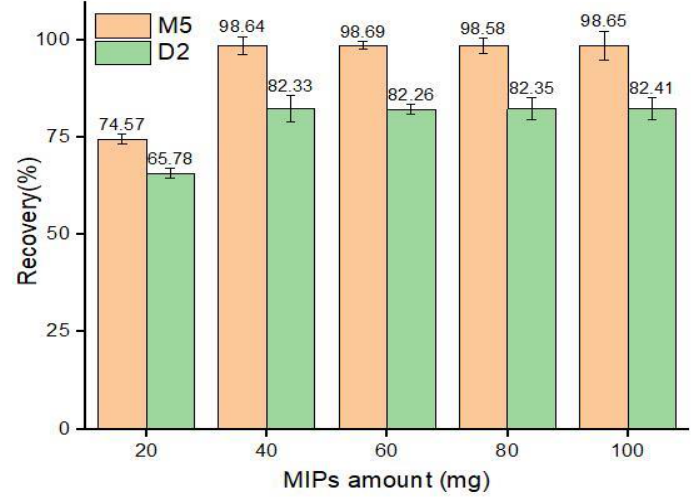
Figure 10. Adsorption recoveries (%) by different amounts of